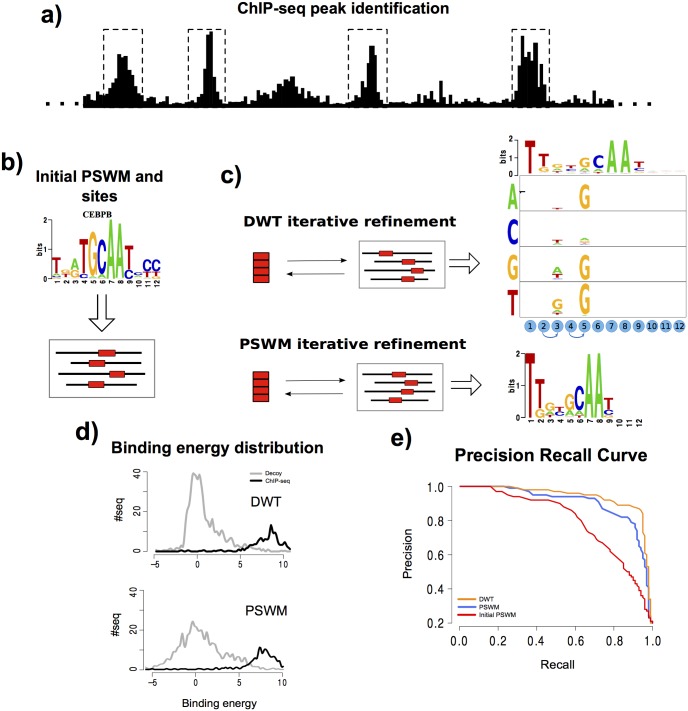
Comparison of DWT and PSWM performance on ChIP-seq data.a) For a given ChIP-seq data-set we use the CRUNCH ChIP-seq analysis pipe-line to identify the top 1000 binding peaks and randomly subdivide these into an training set and a test set of 500 peak sequences each. b) Standard PSWM motif finding is used to determine an initial PSWM motif [22, 27]. c) Using expectation maximization, a PSWM and a DWT model are fitted on the training data. d) Distributions of the predicted binding energies E(S), under both the DWT and PSWM models, of the 500 peak sequences and a set of 2000 random ‘decoy sequences’ that have the same lengths and dinucleotide composition as the peak sequences. e) Precision recall curves demonstrating the ability of the DWT, PSWM, and initial PSWM models to distinguish peak sequences from decoys based on their predicted binding energies.